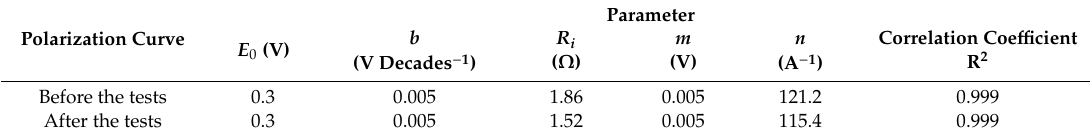
Table 3. Parameters values obtained in modelling the polarization